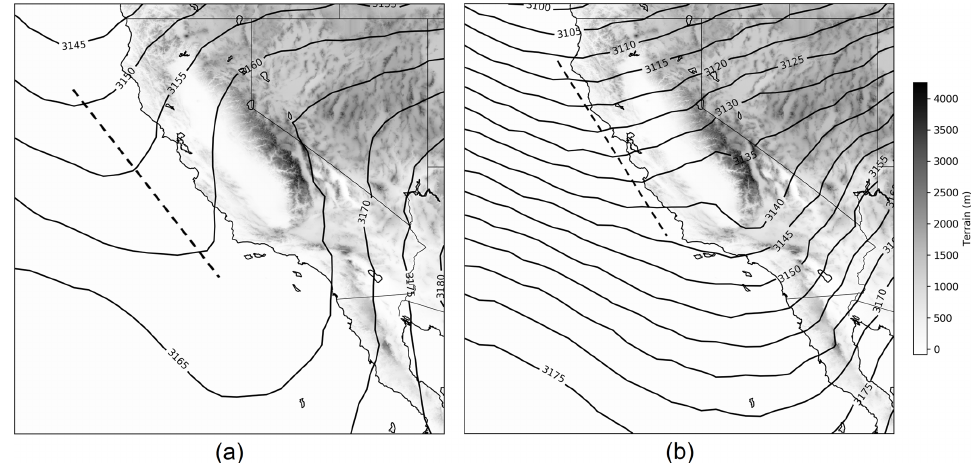
Figure 8. North American Regional Reanalysis 700mb geopotential height (m) for low-level jet speeds less than 7ms − 1 (a) and greater than 12ms − 1 (b) .